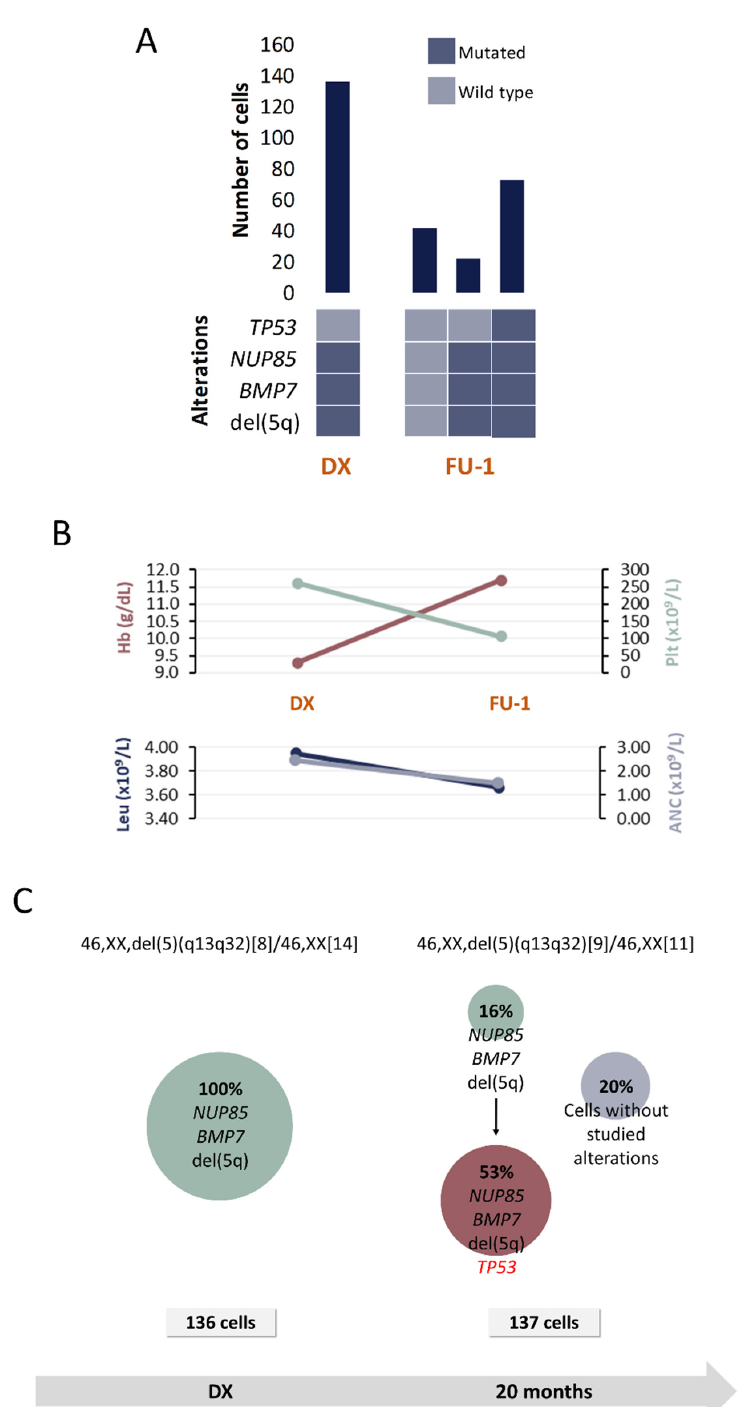
Figure 5. Clinical and molecular characteristics of patient P4. ( A ) Bar plot depicts the number of cells with a given genotype for each clone that was detected at the moment of diagnosis (DX), 1st follow- up (FU-1) and 2nd follow-up (FU-2). Heatmap below the bars indicates the genotype for each clone: dark blue and light blue are used to indicate the mutated or wild-type state, respectively. ( B ) He- matological characteristics such as hemoglobin (Hb), platelet count (Plt), leukocyte count (Leu) and absolute neutrophil count (ANC) are indicated for each analyzed time point. ( C ) Proposed clonal architecture, karyotype and number of analyzed cells for each time point are indicated. Color red distinguishes new acquired alterations in each clone.